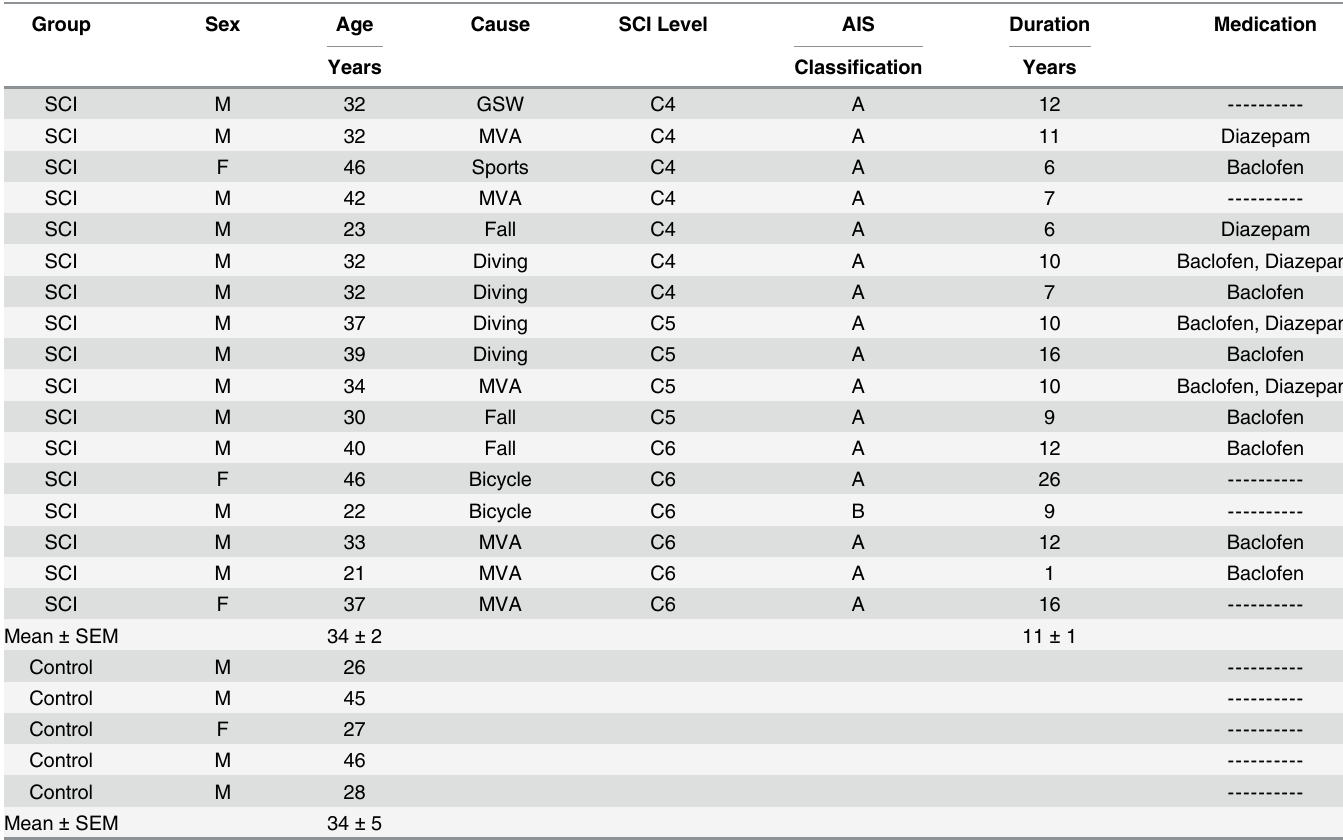
Table 1. Participant Description.